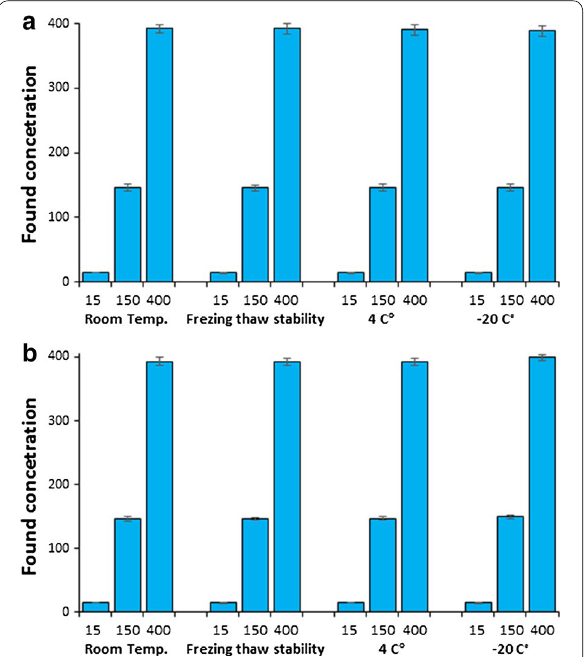
Fig. 4 Conivaptan stability data in human plasma ( a ) and in RLMs ( b ) under different conditions, x-axis is the tested concentrations and y-axis is found concentrations (mean ±